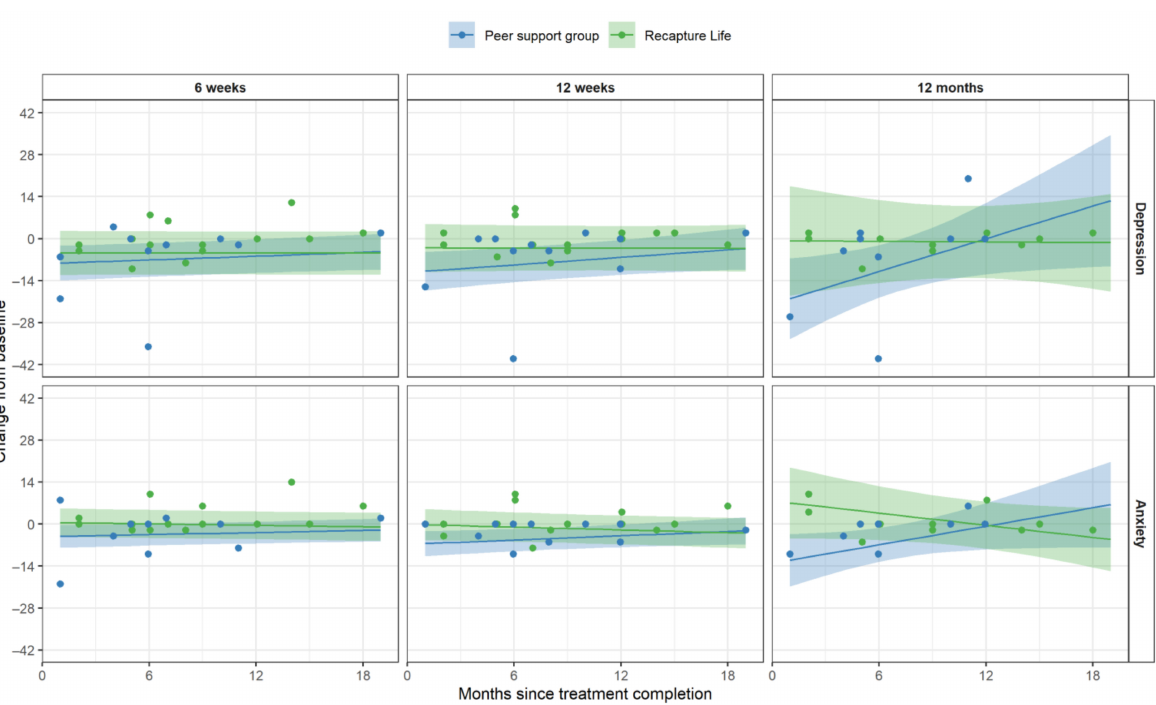
Figure 4. Between-group differences in change in depression and anxiety scores according to participants’ time since treatment-completion, across time-points. Note. Individual scores are displayed, overlaid with thicker lines showing group-specific means and 95% confidence intervals. Participants’ length of time since completing cancer treatment is represented along the X-axis (range: 0–18 months post-treatment); while each column of panels depicts data measured at different study time-points (6-weeks, 12-weeks,